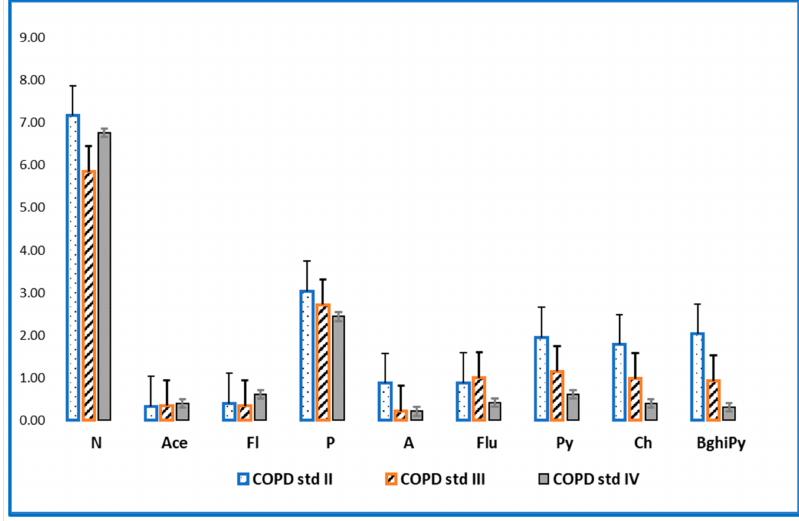
Figure 2. Levels of non-cancerous PAHs (ng/mL) in patients with stage II, III and IV